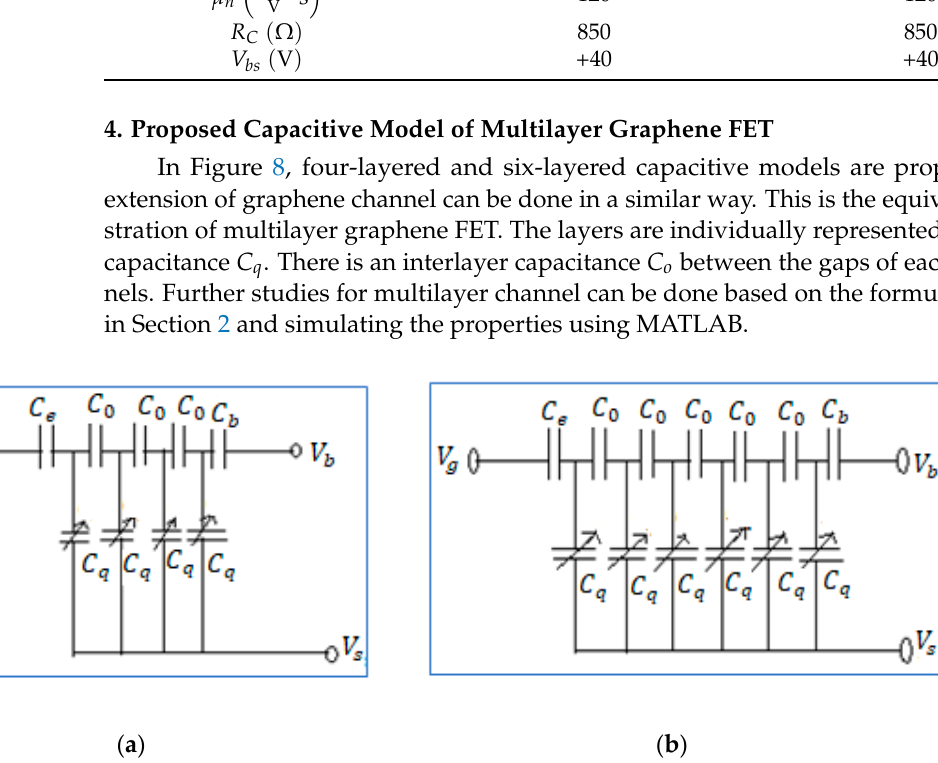
Figure 7. Graphical representation of threshold voltage dependence on back ‒ gate ‒ to ‒ source voltage using silicon dioxide as dielectric.